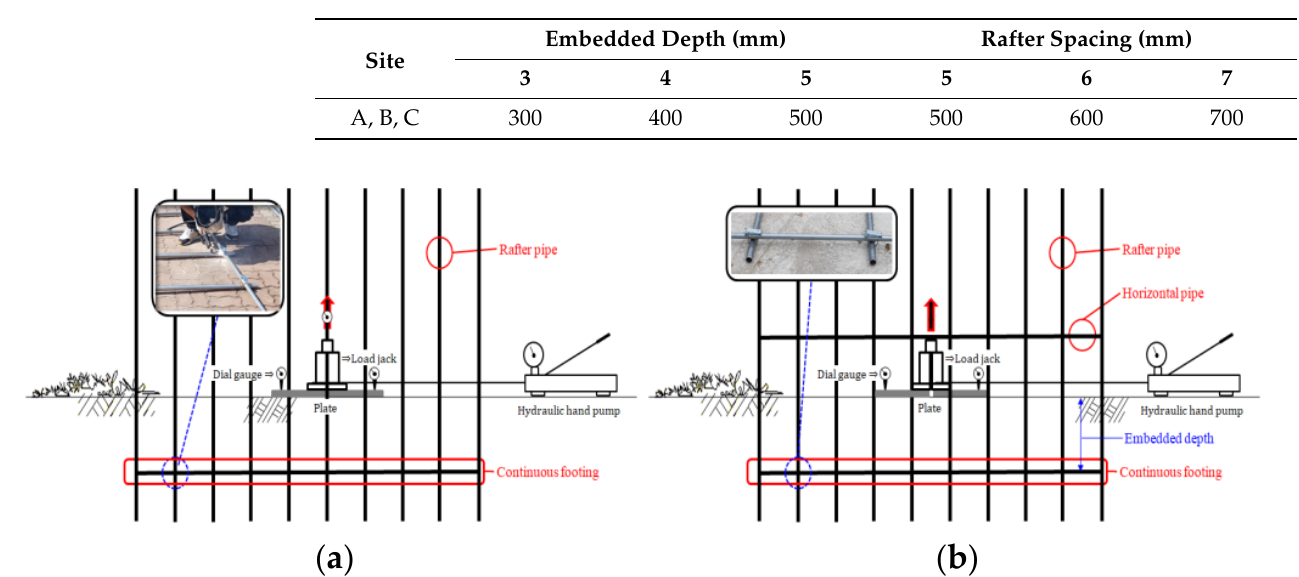
Figure 3. Field static axial tensile load test: ( a ) installed continuous foundation of site A and ( b ) installed continuous foundation of site B and site C.